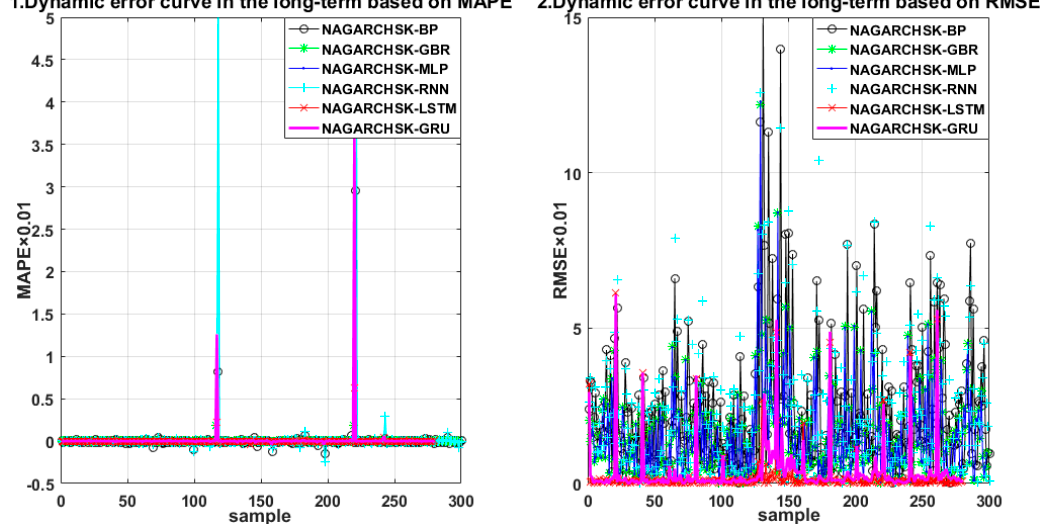
Figure 9. Error scatter distribution of the proposed and benchmark forecasting models considering the feature of time-varying, high-order moment in the short term.